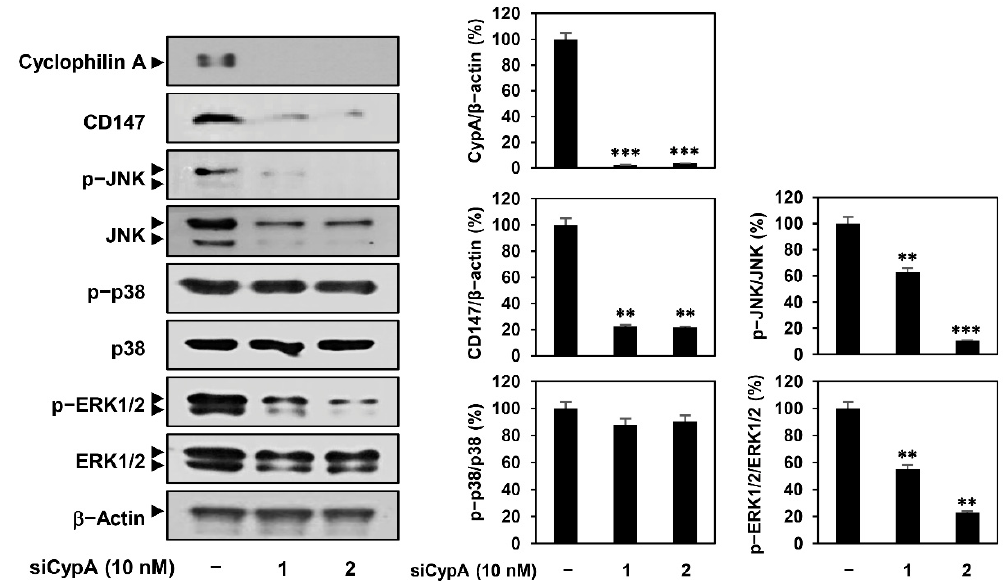
Figure 5. Effect of CypA knockdown on the CD147-mediated MAPK signaling pathway in AGS cells. AGS cells were transfected with CypA siRNAs (10 nM) and incubated for 24 h. Protein levels were detected by western blot analysis and further quantified by densitometry. The level of β -actin was used as an internal control. ** p < 0.01, *** p < 0.001 vs. the control.